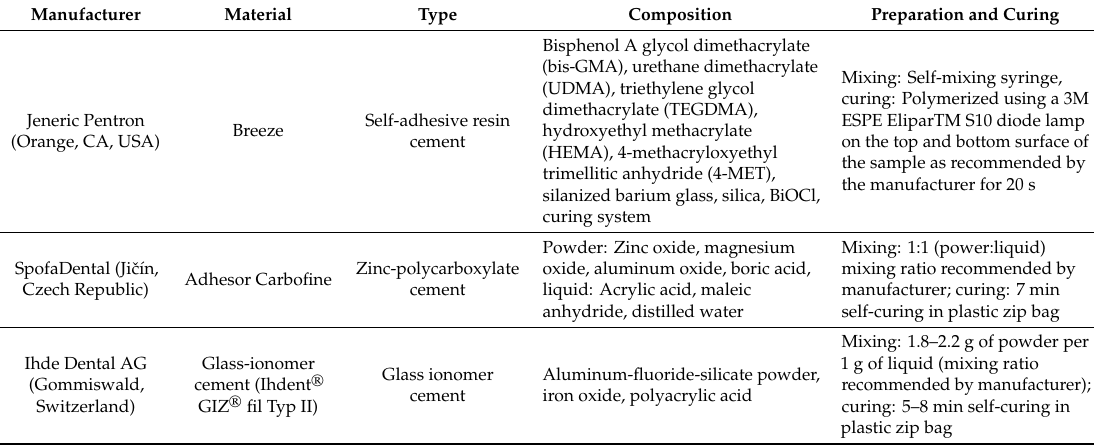
Table 1. The composition of tested materials.